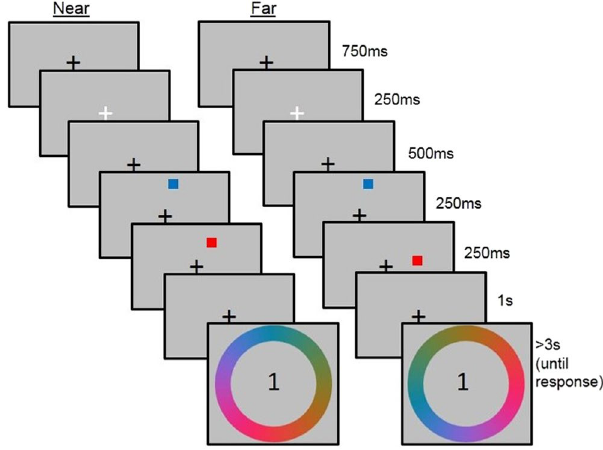
Figure 4. The trial sequence for the Near and Far conditions of Experiment